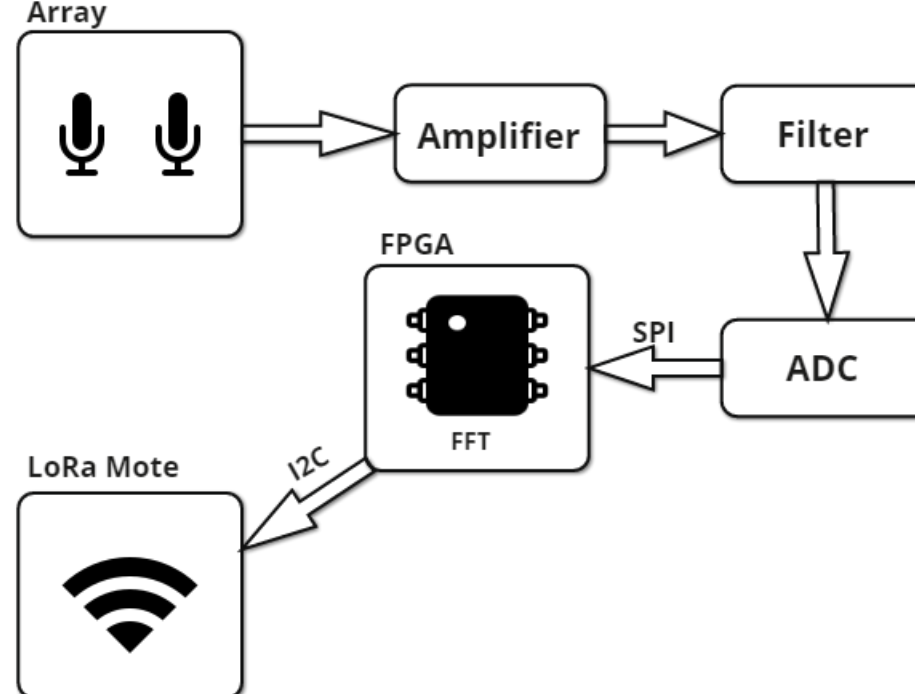
Figure 2. Hardware Block Configuration.